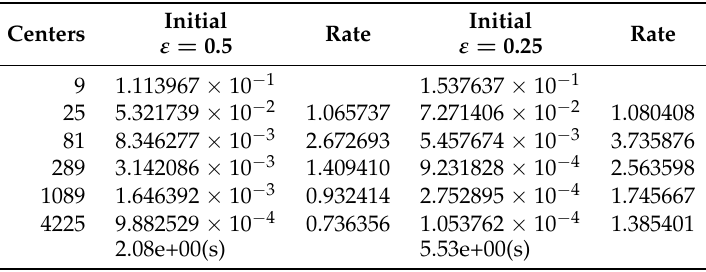
Figure 1. Six scattered data sets used in experiments: N interior Halton points (blue) and 4 ( equally spaced boundary collocation points (red). Table 3. Multilevel